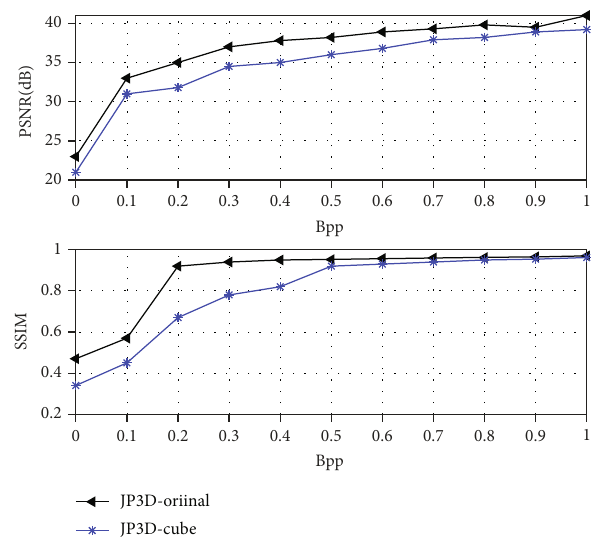
Figure 6: Rate distortion curves of JP3D compression on two image